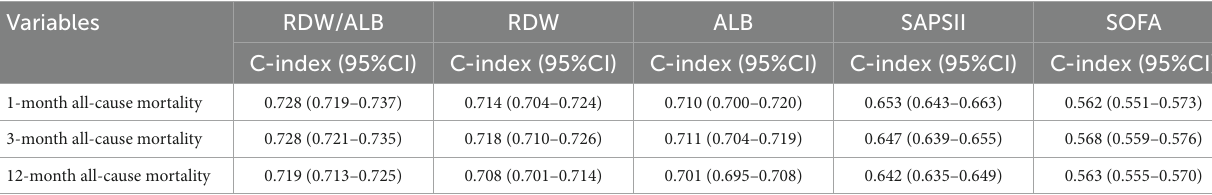
TABLE 4 Predictive value of RDW/ALB, RDW, ALB, SAPSII, and SOFA in all-cause mortality of